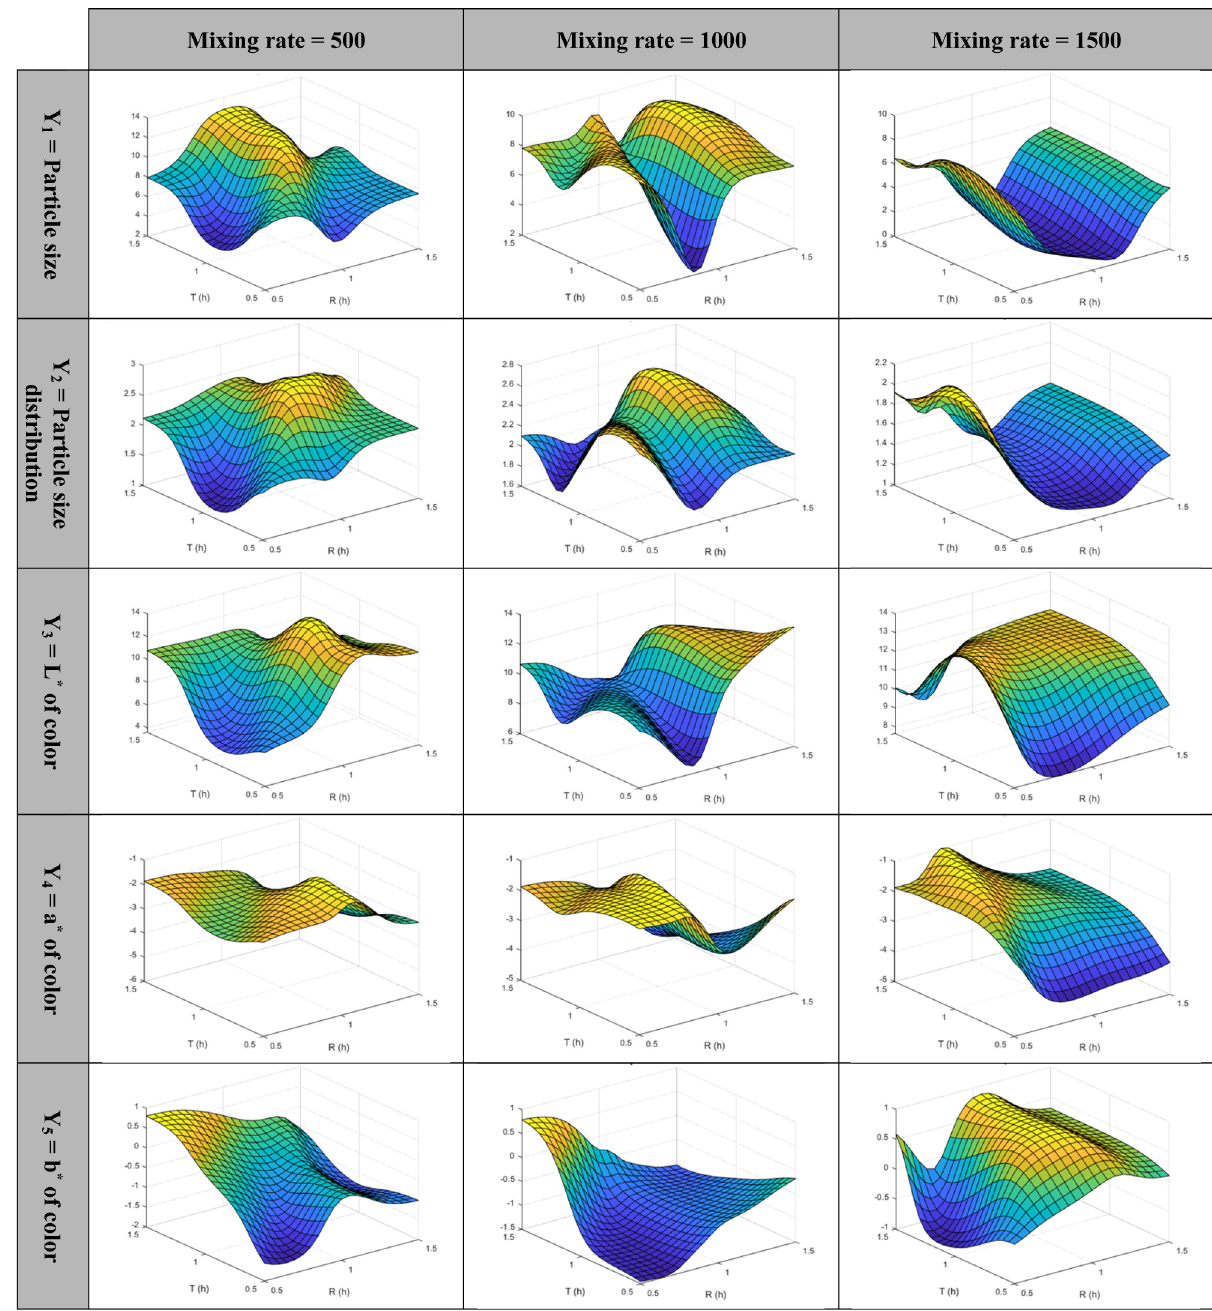
Figure 9: 3D plots of modelling responses (PS, and PSD, and color (L*, a*, b*)) in constant values of mixing